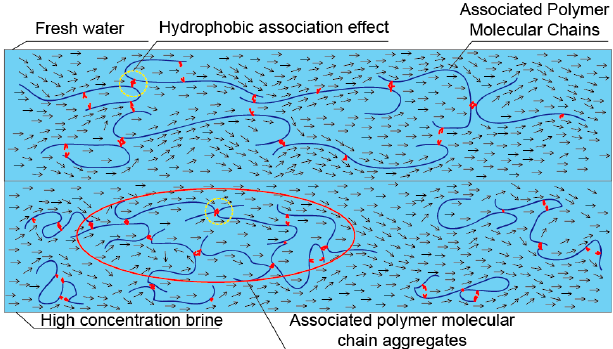
Figure 13. DR effect of polymer molecular chains containing hydrophobic monomers in fresh water and brine.